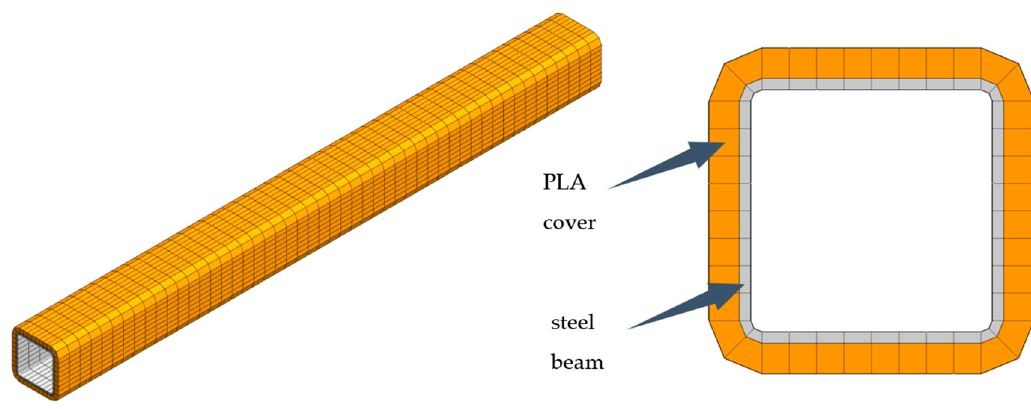
Figure 5. Finite element model of a polylactide-covered beam.